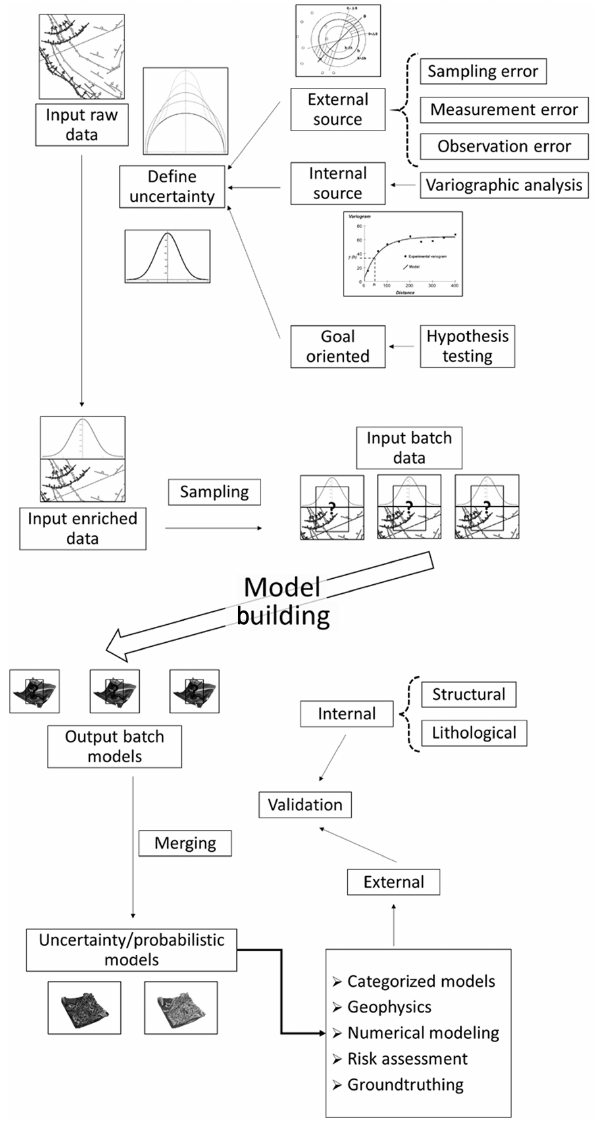
Figure 1. Monte Carlo uncertainty propagation procedure work-